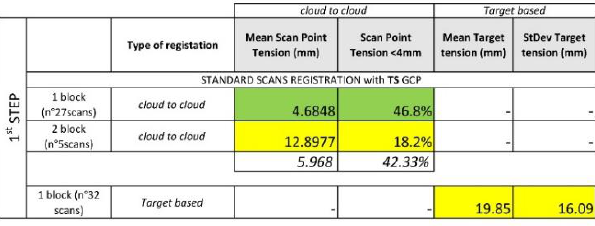
Figure 5. Accuracy results after clouds registration: 1° STEP